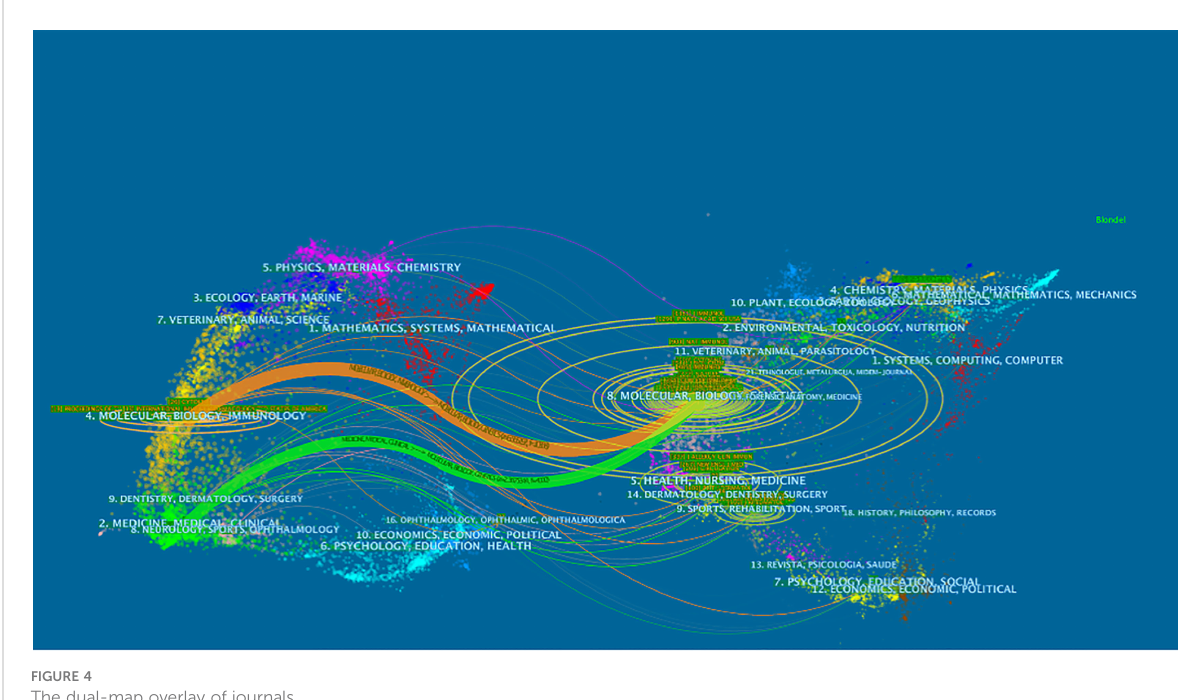
FIGURE 4 The dual-map overlay of